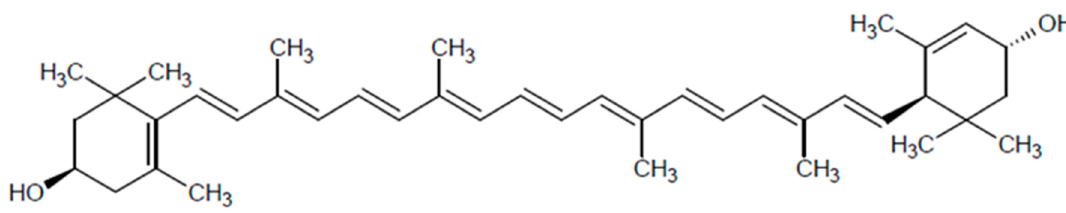
Figure 1. Structure of lutein.